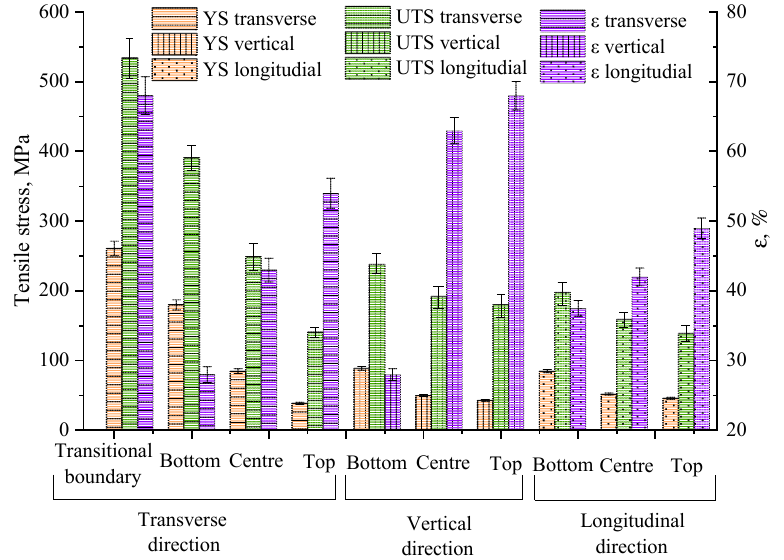
Figure 18. Histograms of the distribution of mechanical property characteristics of C-type copper block samples cut in transverse, vertical and longitudinal directions relative to the growing direc- tion.